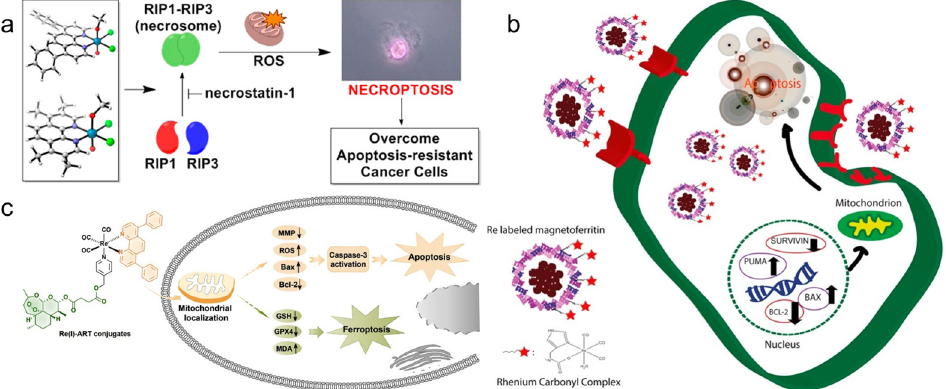
Figure 4. ( a ) Schematic diagram of the process of Re-4a and Re-4b inducing cell necrosis (reproduced with permission from Ref. [84], Copyright 2015, American Chemical Society); ( b ) schematic diagram of the process of Re-magnetoferritin nanoparticles inducing cell necrosis (reproduced with permission from Ref. [116], Copyright 2018, Elsevier B.V.); ( c ) schematic diagram of the process of Re-6a inducing apoptosis and ferroptosis of cancer cells (reproduced with permission from Ref. [86], Cop- yright 2021, Elsevier B.V.).